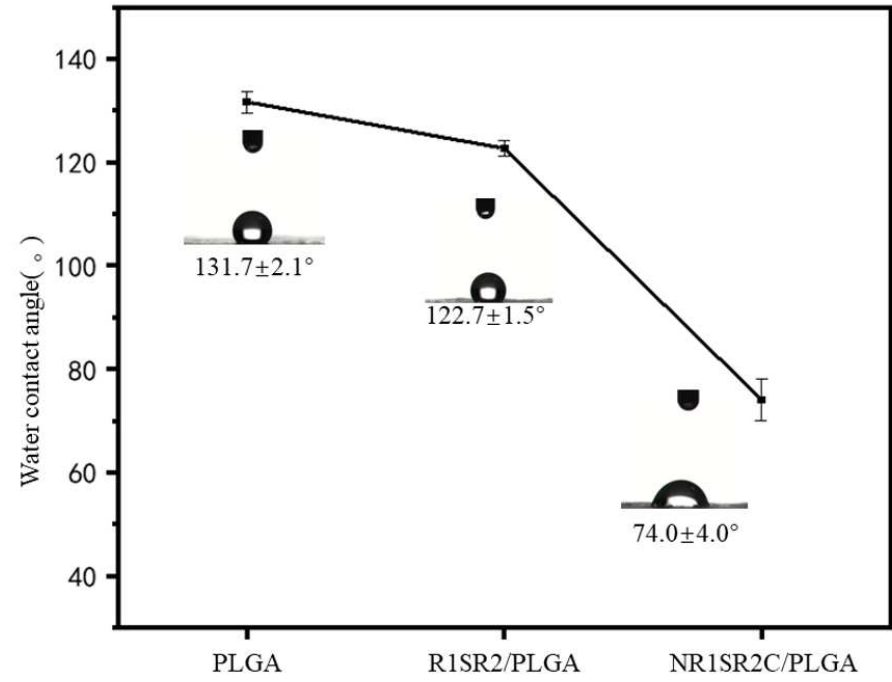
Figure 6. Hydrophilicity of recombinant MiSp/PLGA (20/80) blend and pure PLGA scaffolds ( n = 3).